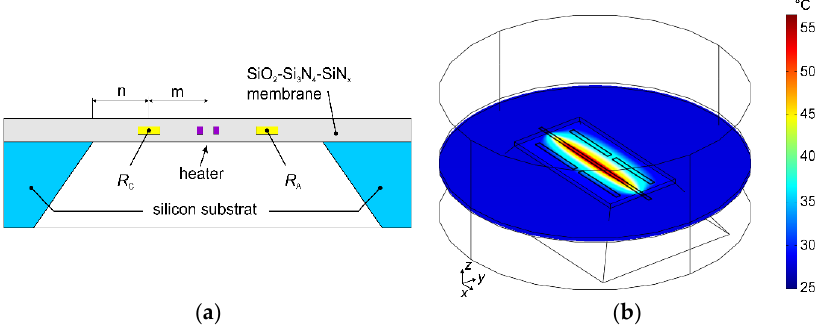
Figure 3. ( a ) Schematic cross section in y -direction of the flow sensor depicted in Figure 1a (m = 137.5 µ m, n = 125 µ m). ( b ) 3D FEM model of the flow sensor. It considers only a narrow cylindrical section around the sensor membrane and the flow channel above. The colors illustrate the temperature distribution at the cross section through a membrane and parallel to the x–y -plane. For this particular simulation a rectangular flow channel of 0.5 mm height and 1 mm width was assumed, with an airflow in y -direction and 1 m / s mean flow velocity. The heating power amounts to 3 mW and the ambient temperature to 25 ◦ C (which is also the fluid